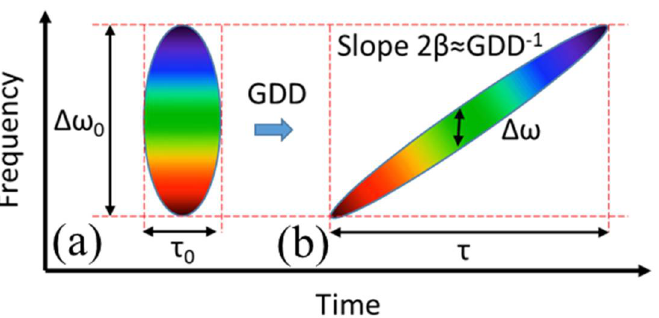
Figure 1. Time-bandwidth distribution for ( a ) Fourier-transform limited laser pulse and ( b ) the laser pulse that is linearly same laser pulse that is linearly chirped.